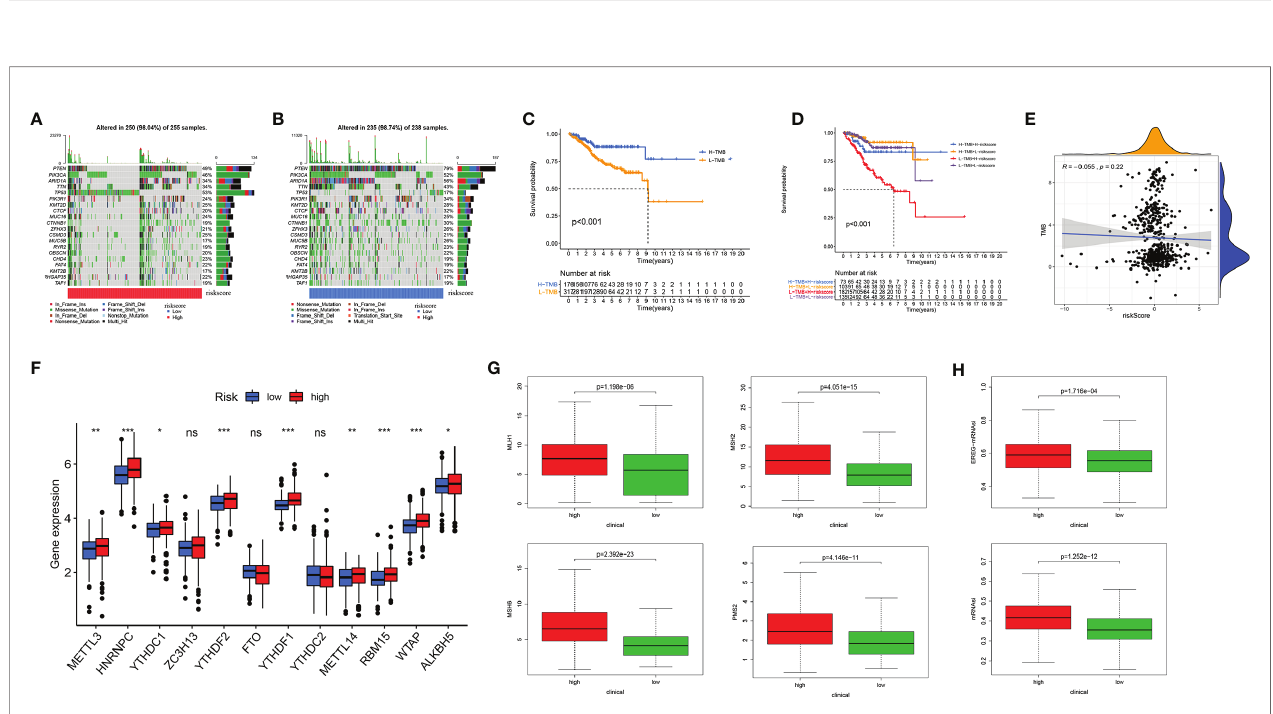
FIGURE 7 | Tumor mutational burden (TMB), somatic mutation, N 6 -methyladenosine, and microsatellite instability (MSI) analysis. Oncoplot displaying the somatic landscape of EC with high-risk group (A) and low-risk group (B) ; the genes are sorted according to their mutation frequency. (C) Survival analysis between high- TMB and low-TMB EC patients. (D) Two-factor survival analyses of risk score and TMB level. (E) Relationship between TMB and EMT-related risk score. (F) The expression level of main genes of m 6 A writers, erasers, and readers (HNRNPC, YTHDF1, YTHDF2, RBM15, and WTAP) in high-risk and low-risk groups. (G) The expression of MLH1, MSH2, MSH6, and PMS2 in high-risk and low-risk groups. (H) mRNA stemness indices between high-risk and low-risk groups. EC, endometrial cancer. Adjusted p-values were shown as ns, not signi fi cant; *p < 0.05; **p < 0.01; ***p <